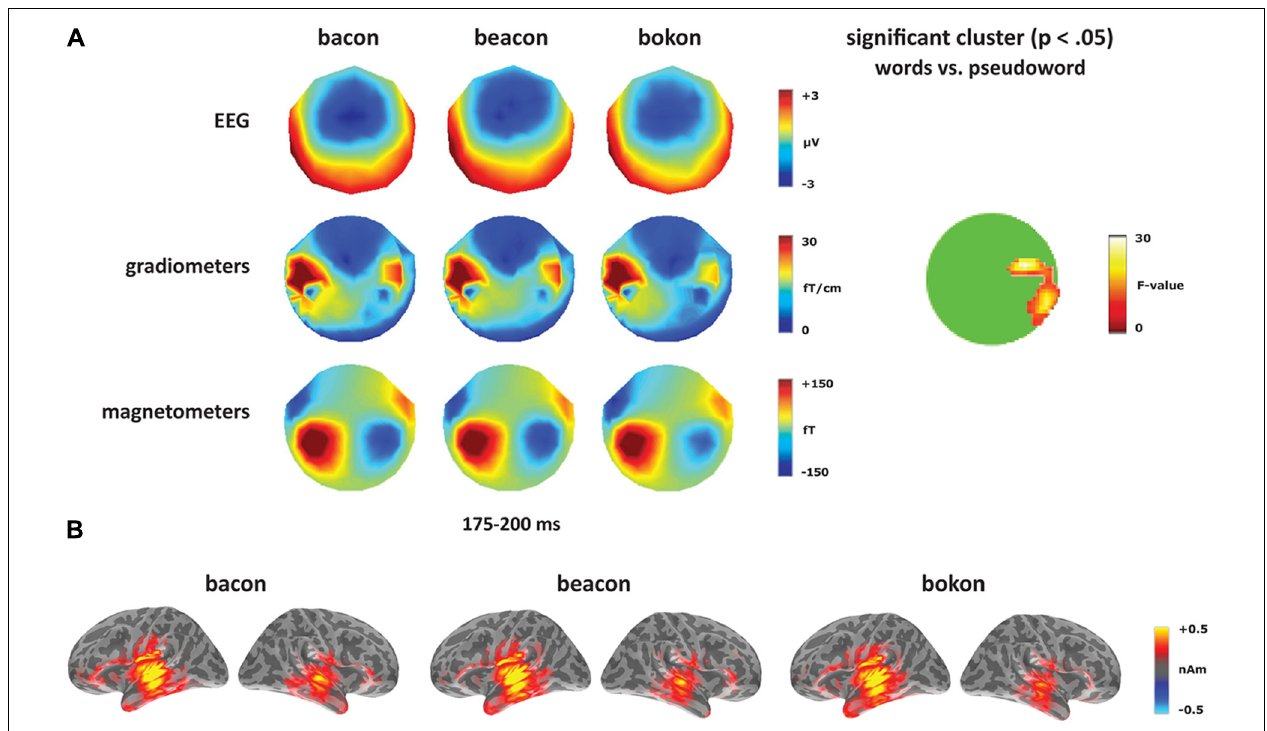
FIGURE 5 |Word–pseudoword contrast: [-on]. (A) Topographies for [-on] deviants ( bacon, beacon, bokon ) from 175 to 200 ms, and the location of the significant cluster from the sensor analysis. (B) Source activation for [-on] deviants from 175 to 200 ms.